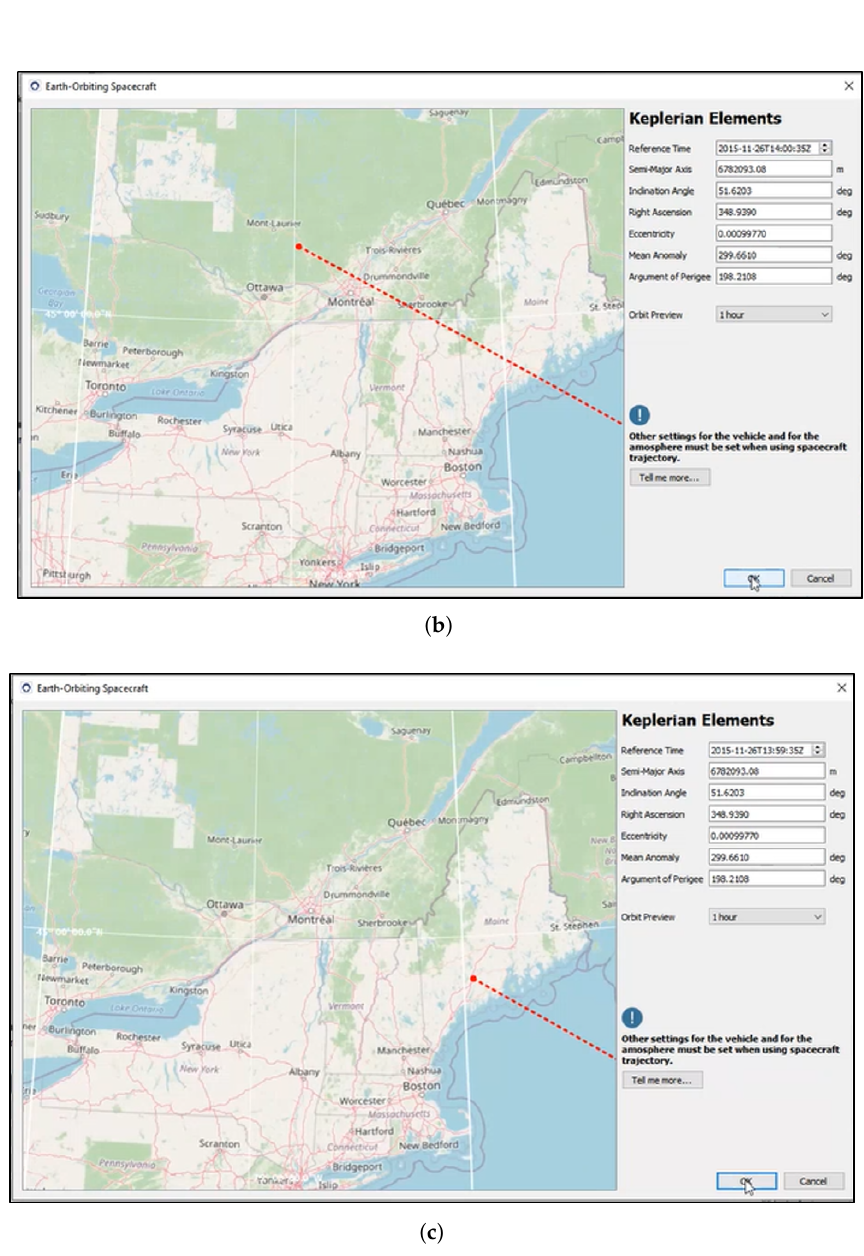
Figure 9. Three instances created by the Orolia Simulator. ( a ) Instance-1. ( b ) Instance-2. ( c )